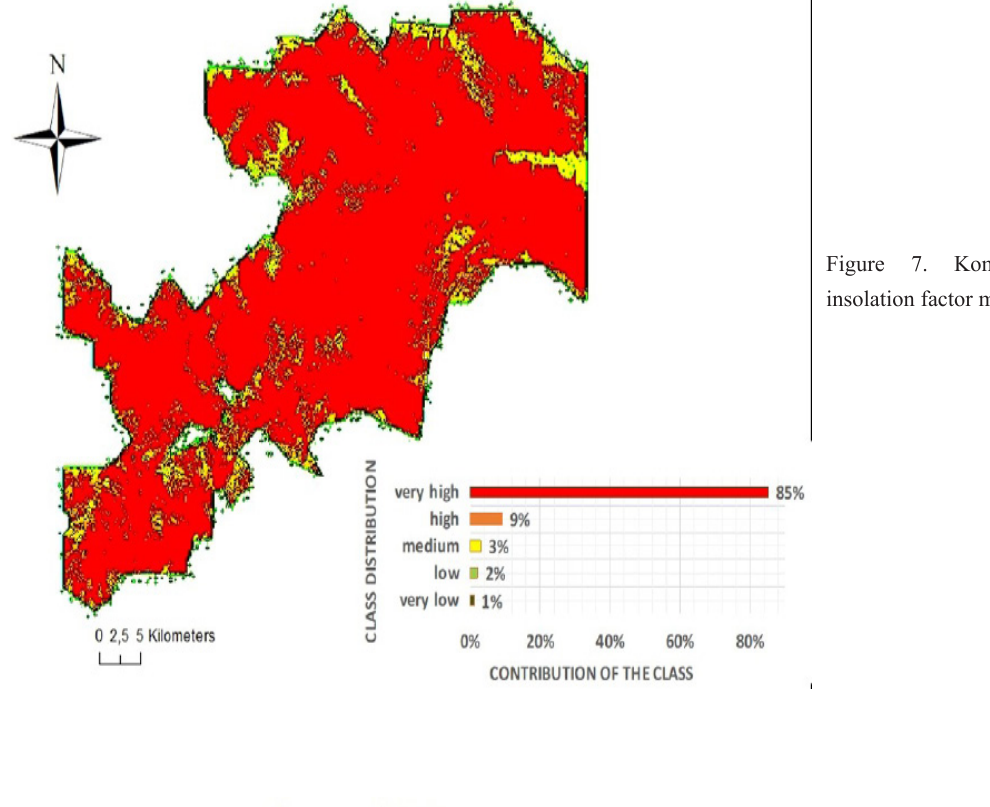
Komati Gorge ruggedness factor